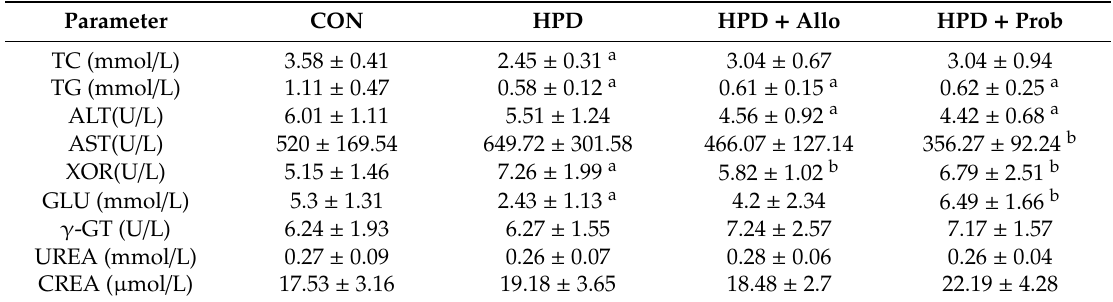
Table 3. Biochemical parameters in the second experiment chicken model of